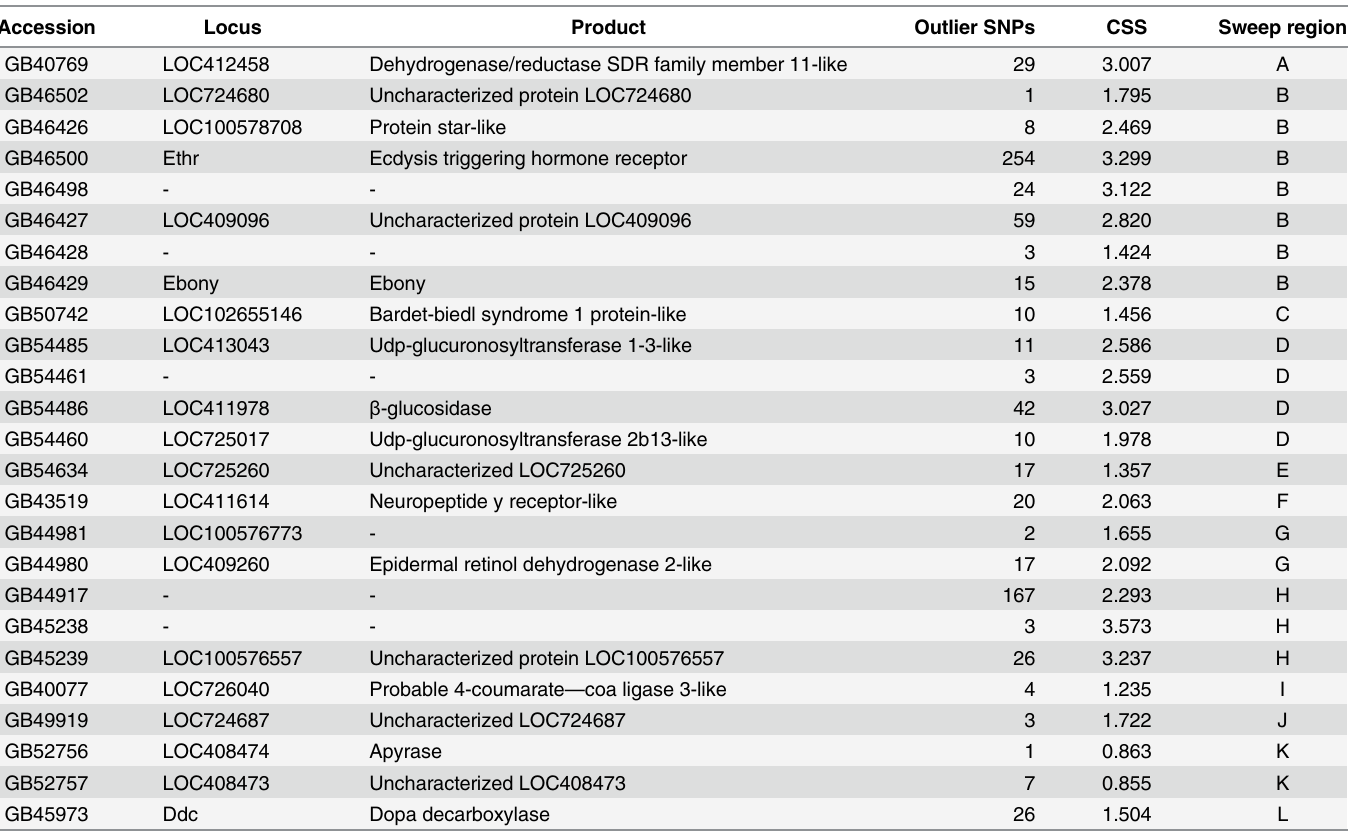
Table 1. Gene candidates in the vicinity of selection signals.